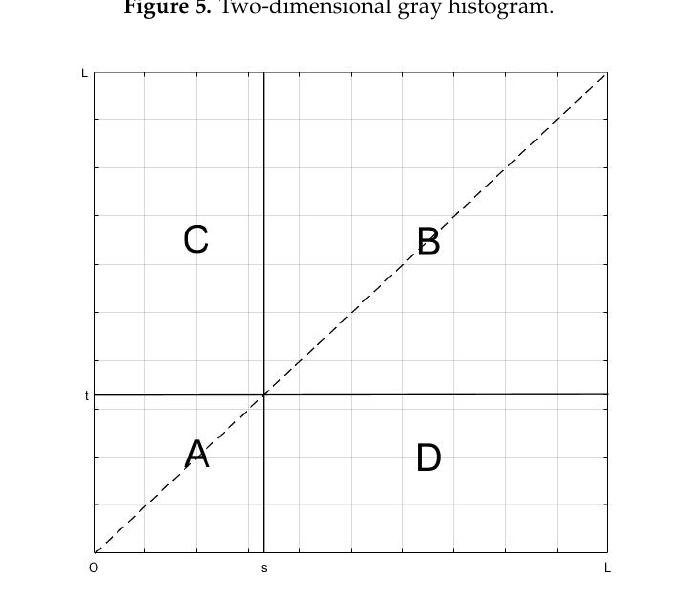
Figure 6. Two-dimensional histogram XOY plan